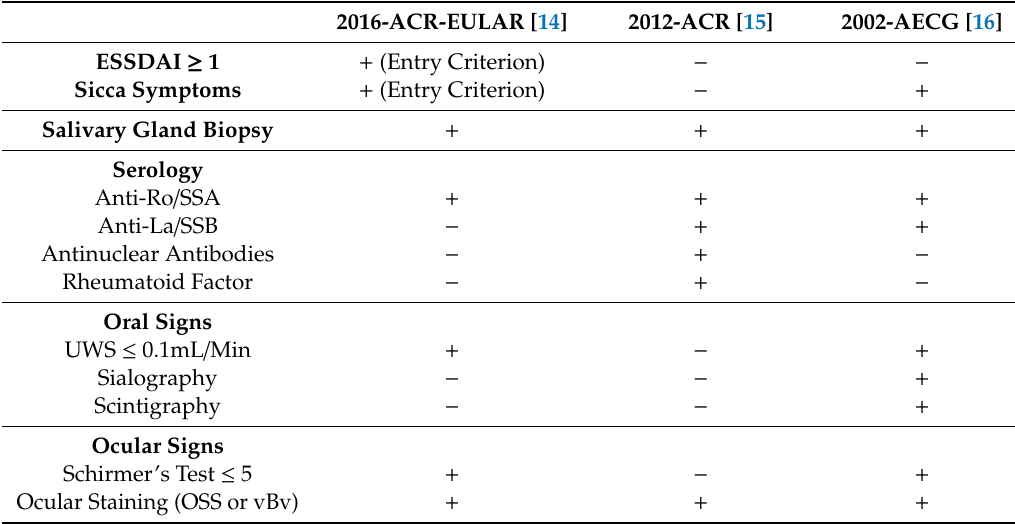
Table 1. Comparison of classification criteria sets for pSS